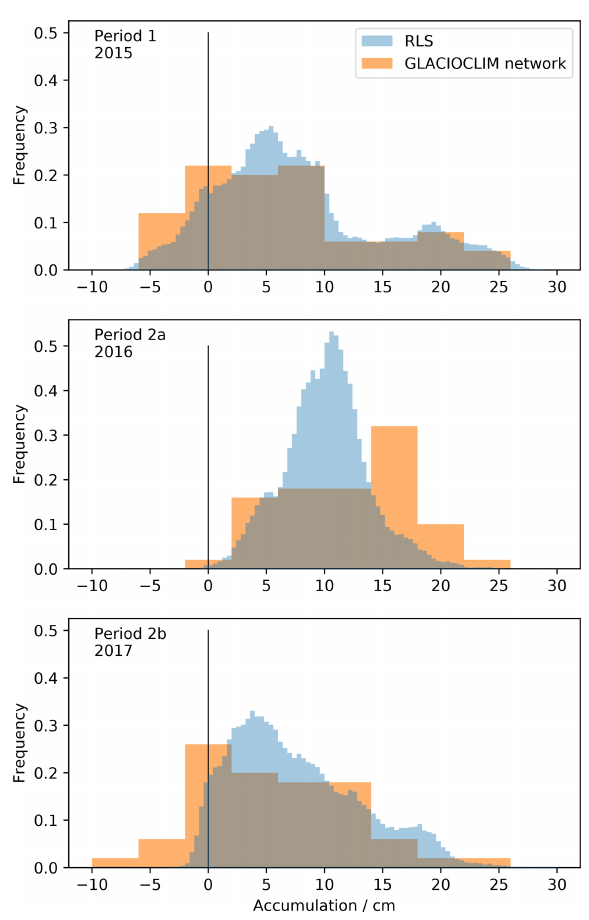
Figure 4. Distribution of the annual accumulation in the scanned area (blue bars) and from the 50 stakes of the GLACIOCLIM net- work near Dome C (orange